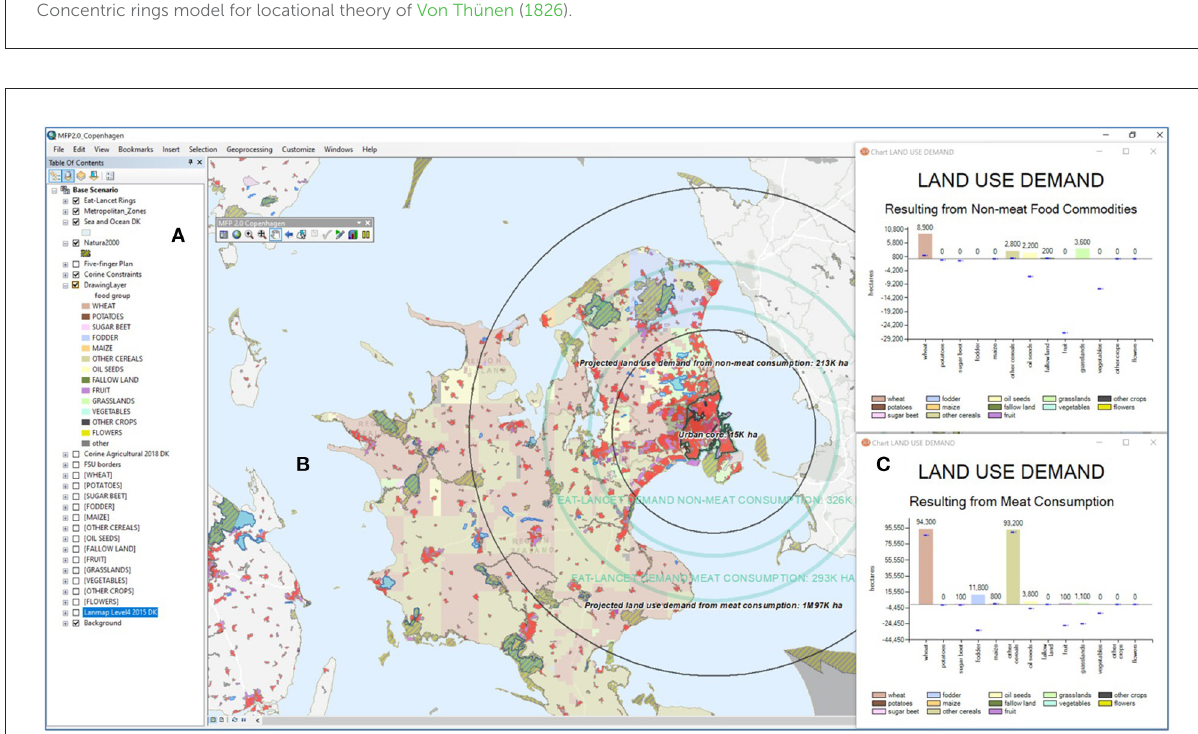
FIGURE2 Main interface of the MFP Tool featured by a dynamic GIS, which contains three main frames: (A) the map library, (B) the interactive map area, and (C) two dynamic charts showing supply and demand figures for the food system of the Copenhagen city region.